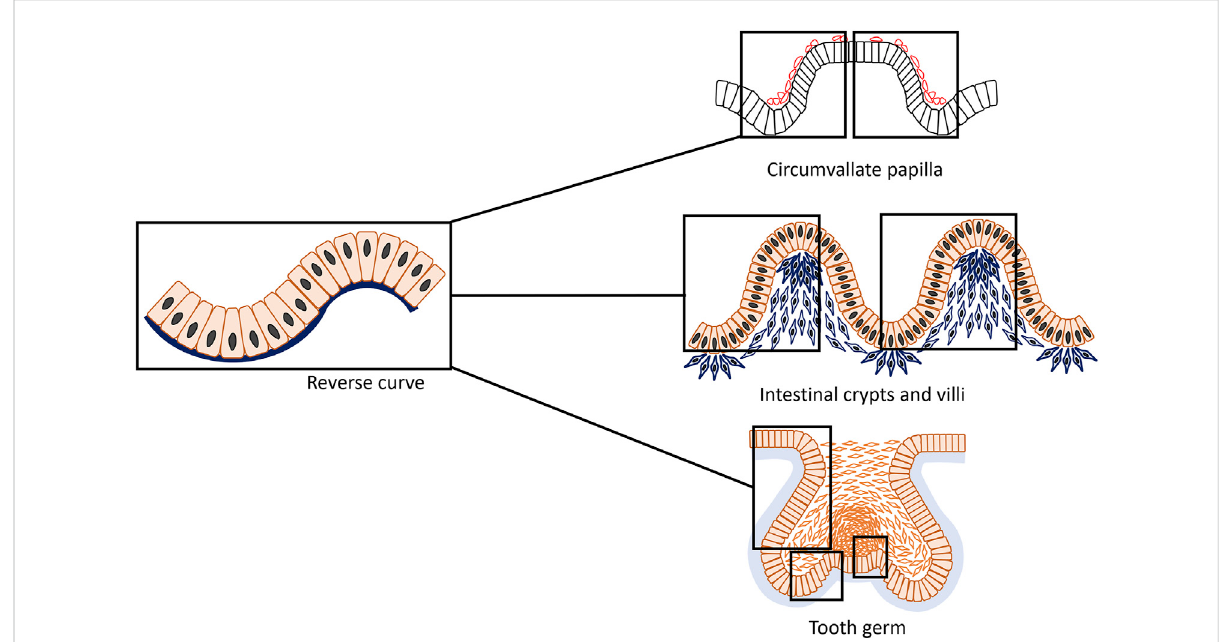
a repetitive pattern giving rise to the crypts and villi; whereas in tooth development, reverse curves are found in a more complex and diverse